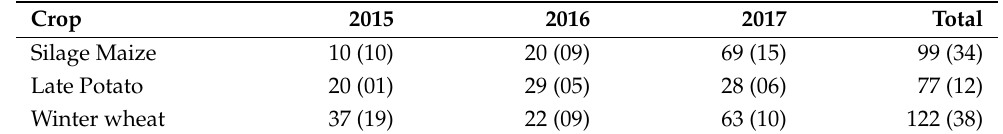
Table 2. Arable fields monitored. In brackets are the fields monitored with Digital Hemispheric Photography (DHP).